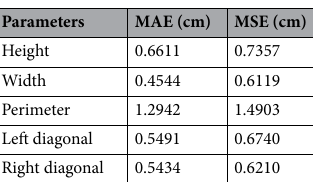
Table 4. Mean of absolute errors (MAE) of the measurement